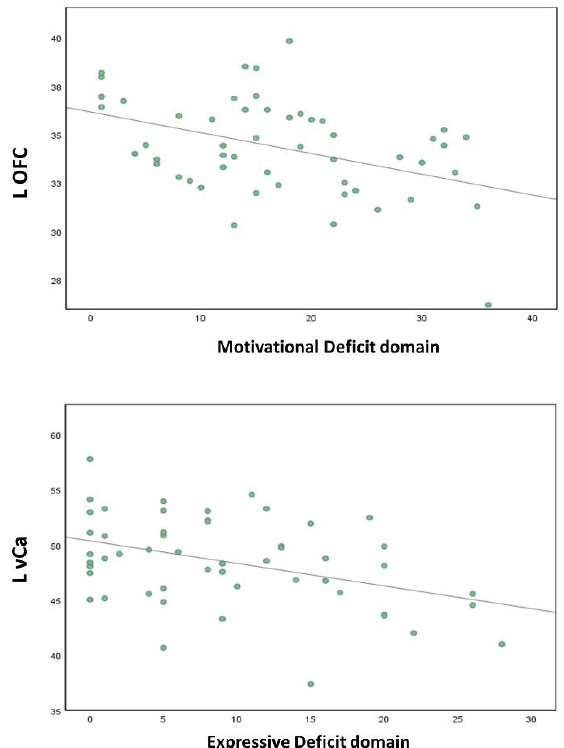
Figure 2. Correlations between the left orbitofrontal cortex and the left ventral caudate with the negative symptom domains. L: left; OFC: orbitofrontal cortex; vCa: ventral caudate. The left OFC correlates with the Motivational Deficit domain (correlations remain significant after controlling for the effects of the confounding factors), and the left vCa correlates with the Expressive Deficit domain (the p -values of these correlations are much higher than the original ones).